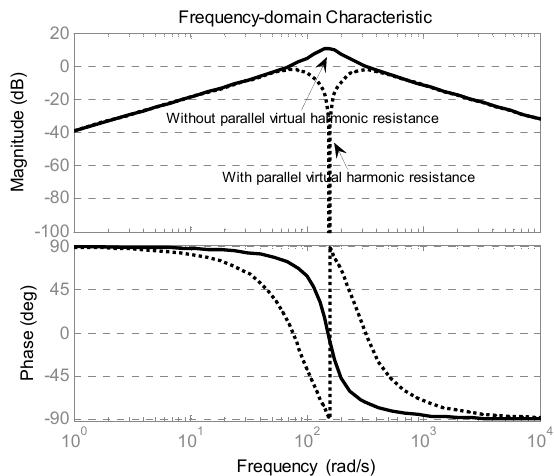
Figure 9. The source output impedance with/without parallel virtual harmonic resistance